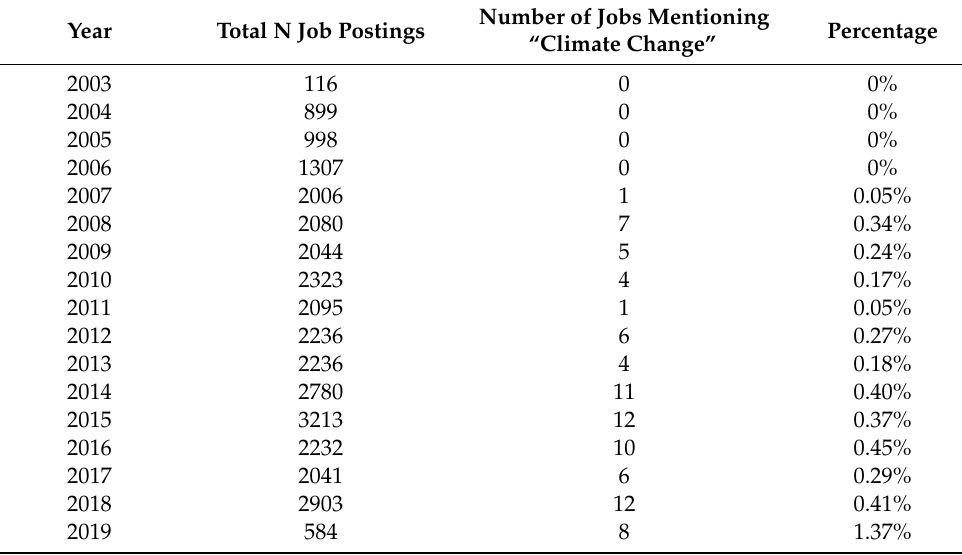
Table 2. Analysis of Data from Publichealthjobs.org / .net from